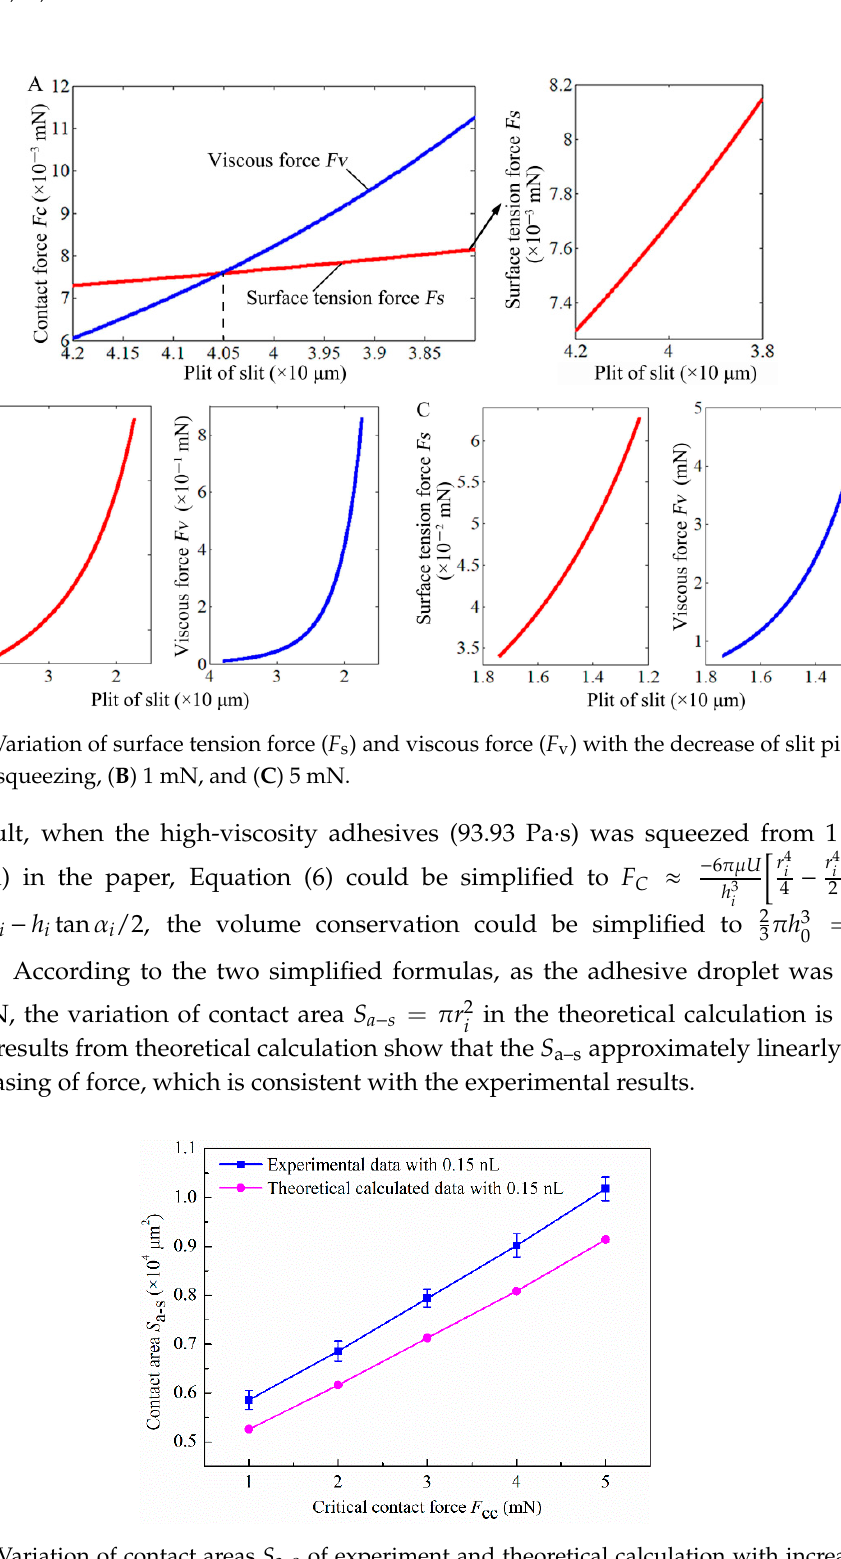
Figure 8. Variation of contact areas S a–s of experiment and theoretical calculation with increase of critical contact force ( F CC ).